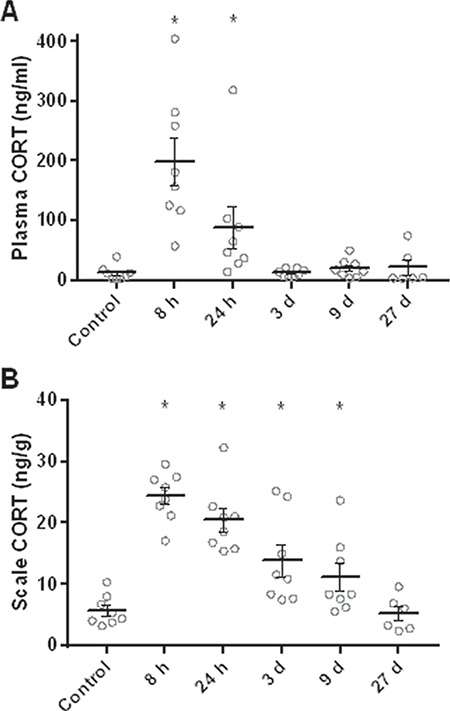
Effects of a cortisol (CORT) implant on plasma cortisol and scale cortisol content over a period of 27 days. (A) Cortisol levels in plasma. (B) Cortisol levels in scales. Significantly increased levels compared to an unstressed control group are indicated by asterisks. Sample size is 8 in all groups, except group 27 days (n = 6). Data are mean ± SEM